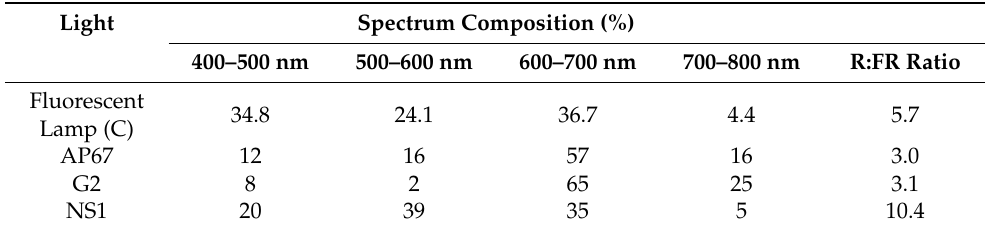
Table 1. Spectral distribution of the four light